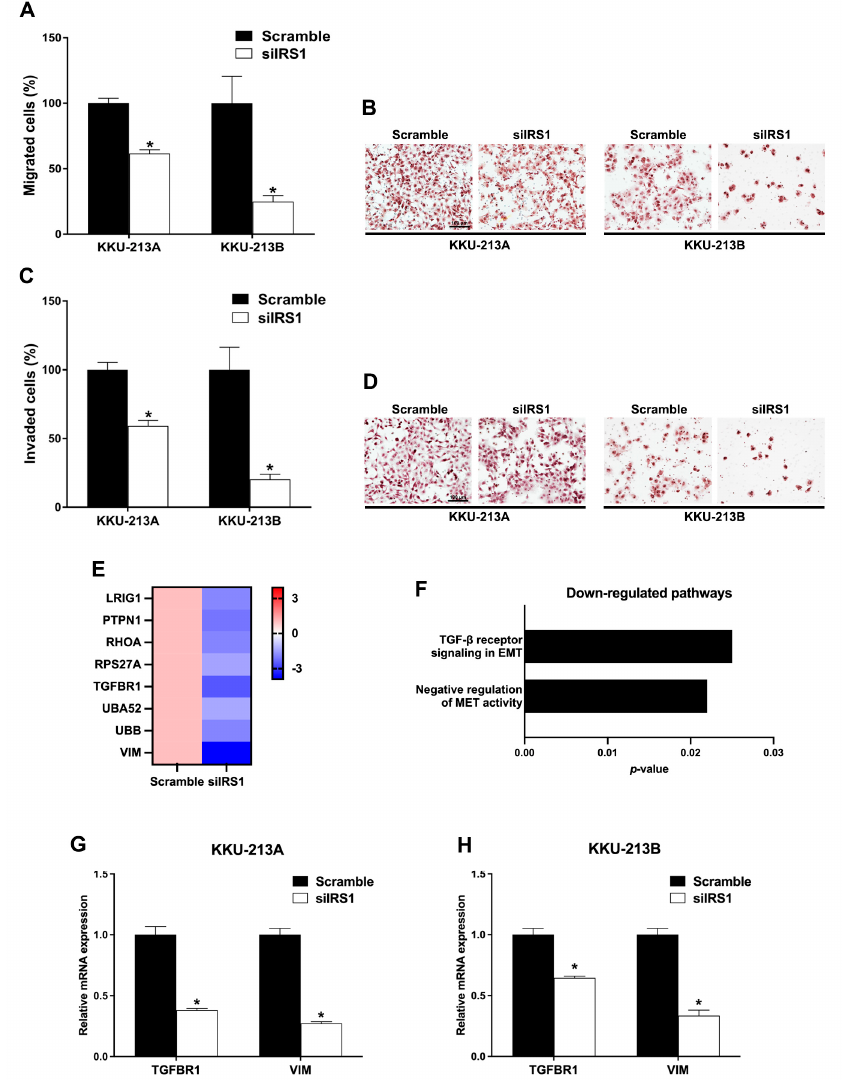
Figure 8. Effect of IRS1 knockdown on cell migration and invasion of CCA cell lines. ( A ) Percentage of migrated cells and ( B ) hematoxylin staining of migrated cells after IRS1 knockdown at 18 h post-migration. ( C ) Quantification of the transwell invasion assay and ( D ) hematoxylin staining of invaded cells after IRS1 knockdown at 18 h post-invasion. ( E ) Heatmap represents fold changes of down-regulated EMT genes investigated by RNA sequencing. ( F ) Down-regulated pathways in IRS1 knockdown KKU-213B cells analyzed by Reactome pathway analysis. ( G , H ) Relative mRNA levels of TGFBR1 and VIM in IRS1 knockdown cells. * p -value < 0.05 compared with scramble